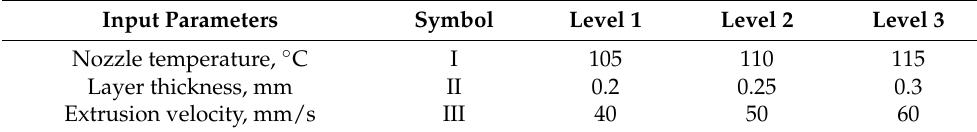
Table 3. Selected parameters and levels for Taguchi analysis.